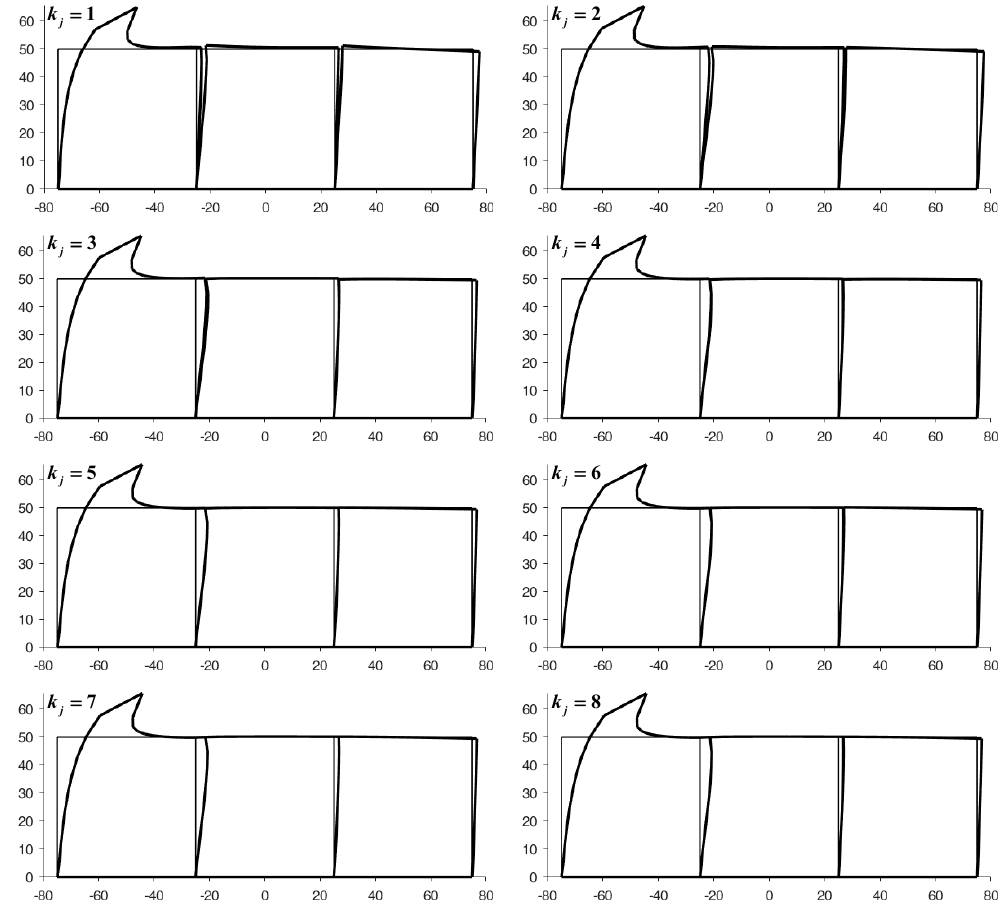
Figure 17. Stabilization cycle on the elements of the same row: deformed configurations provided by the k j -th left-to-right-to-left iteration, for 1 ≤ k j ≤ 8 (Thin line: undeformed configurations. Thick line: deformed configurations. Amplification factor of the displacements: k = 200 ).